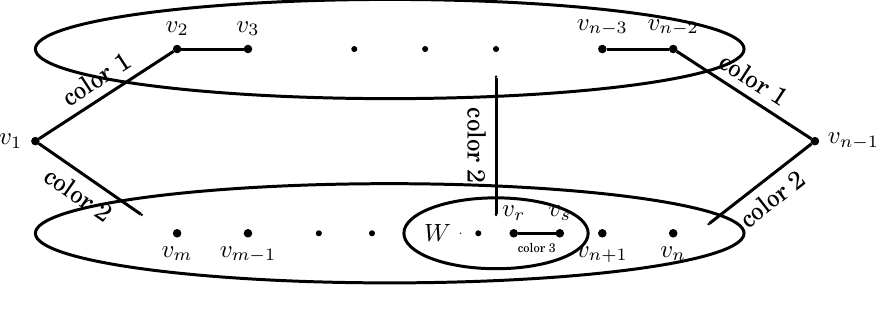
Figure 3: Subcase 2.2.1 of the proof of Theorem